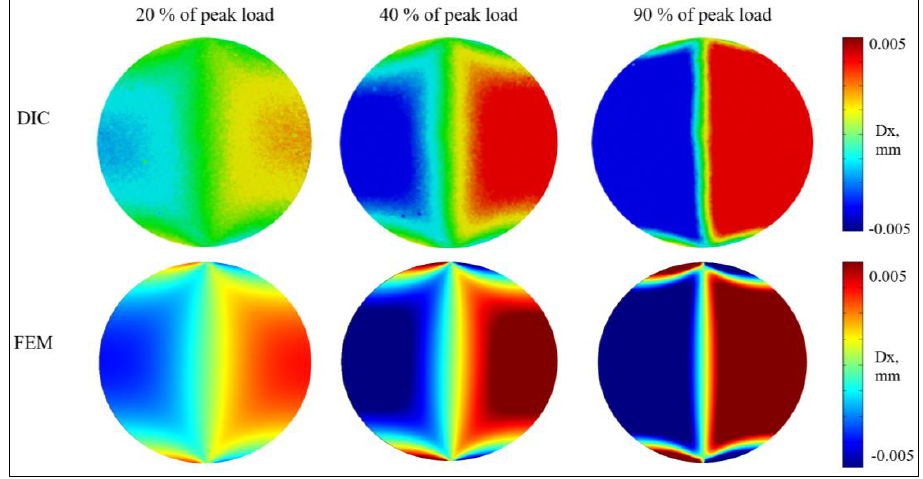
Figure 13. Changes in horizontal displacement ( Dx ) along the centerline: DIC vs. simulation results.